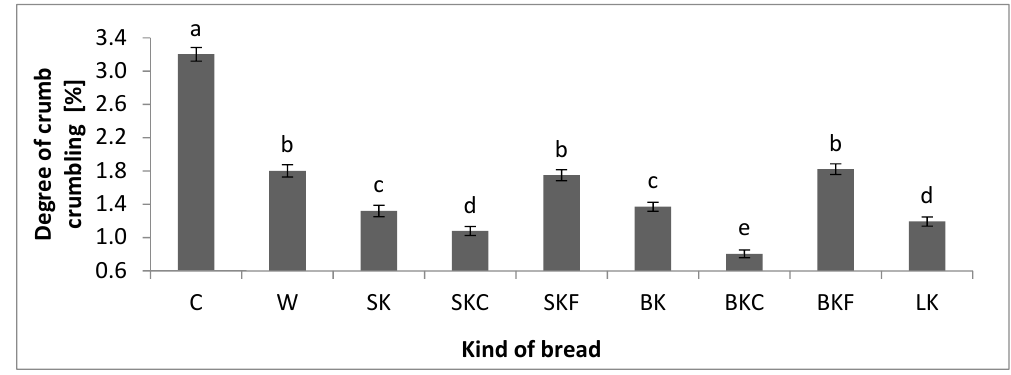
Figure 6. Degree of crumb crumbling of gluten-free bread with ground flaxseeds, C—control gluten-free bread, W—gluten-free bread with whole flaxseeds, SK, SKC, SKF, BK, BKC, BKF, LK—gluten-free bread with ground flaxseeds obtained by the following: SK—whole fraction obtained by short-knife grinding (20 s), SKC—coarse fraction by short-knife grinding (20 s), SKF—fine fraction by short-knife grinding (20 s), BK—whole fraction by short-knife grinding (20 s) and ball milling (60 s), BKC—coarse fraction by short-knife grinding (20 s) and ball milling (60 s), BKF—fine fraction by short-knife grinding (20 s) and ball milling (60 s). LK—long-knife grinding (80